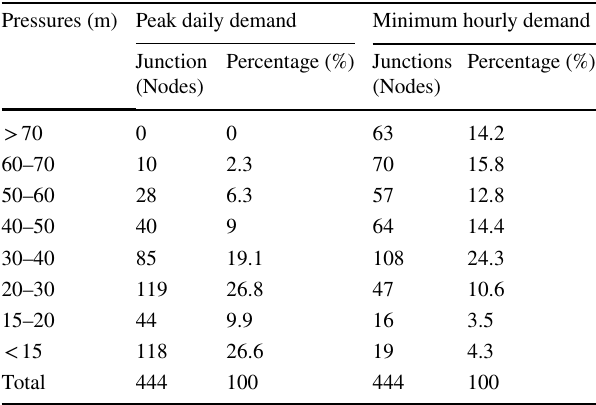
Table 8 Distribution of pressure during peak daily and minimum hourly demand Pressures (m) Peak daily demand Minimum hourly demand